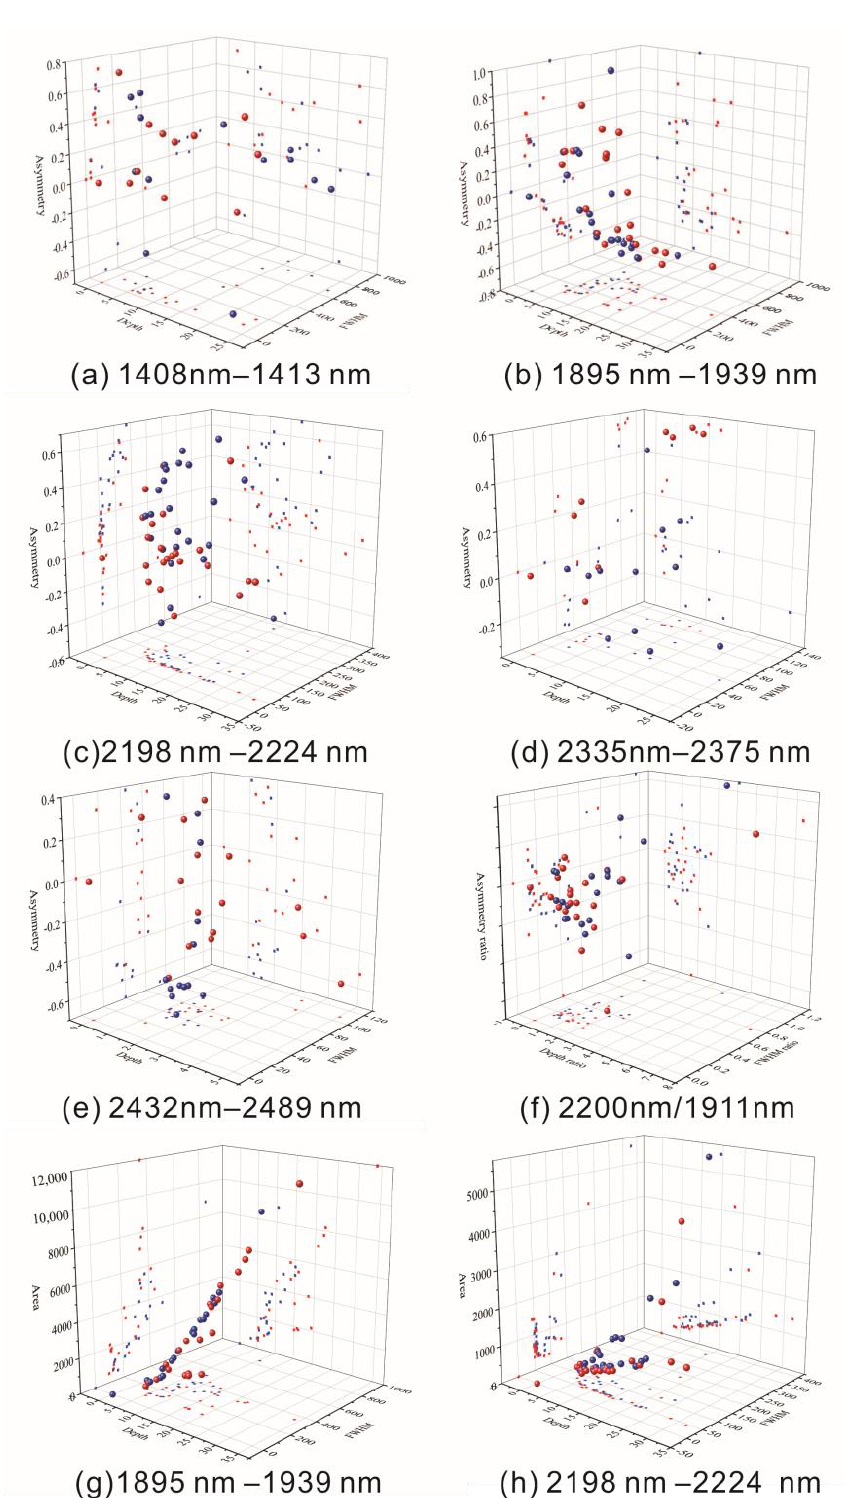
Figure 8. Three-dimensional scatter diagram of depth (Dep), full width at half-maximum (FWHM), and the asymmetry (Asy) area (Are). (Red represents Li-rich pegmatite, and blue represents Li-poor pegmatite.)